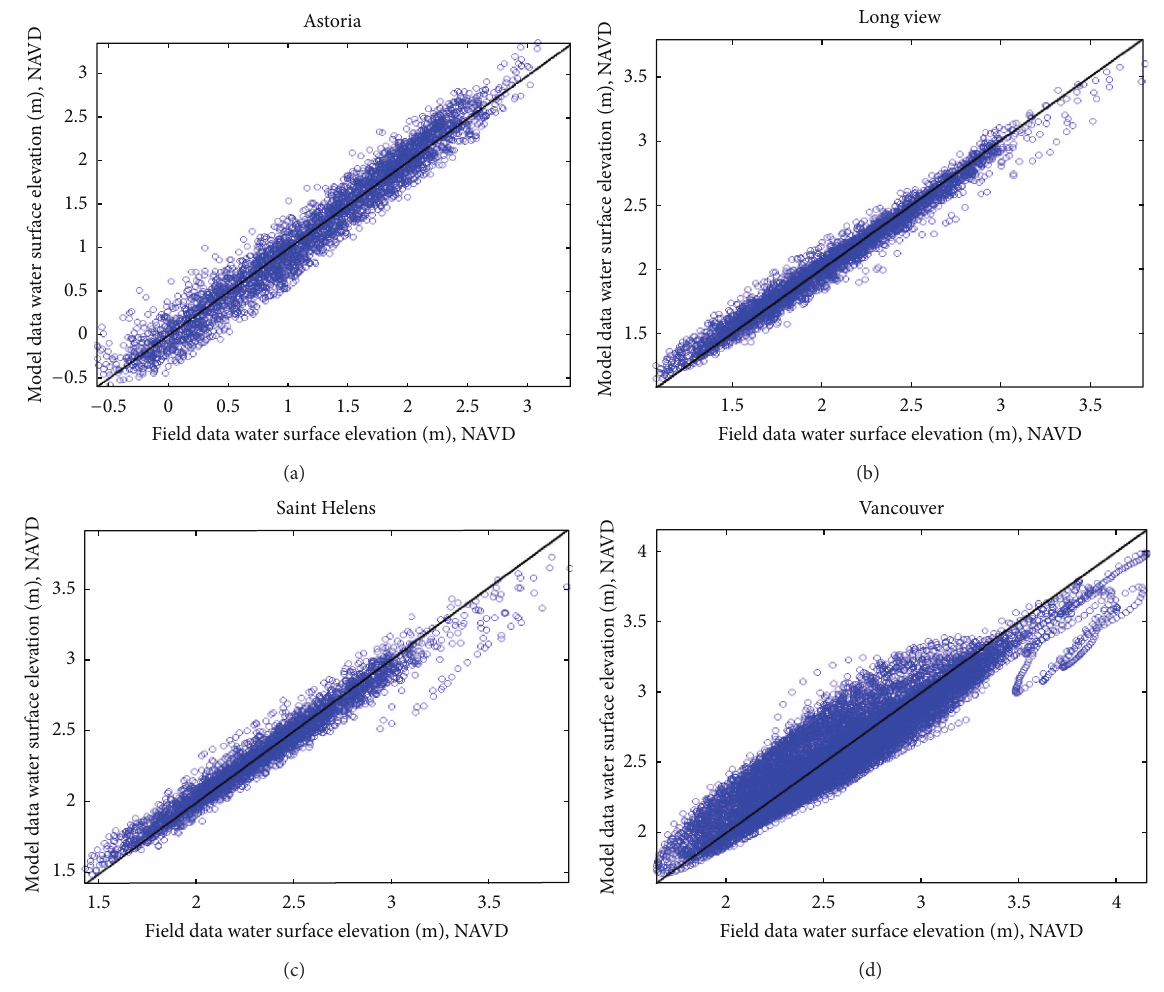
Figure 6: Water surface elevation box at (a) Astoria, (b) Longview, (c) Saint Helens, and (d)